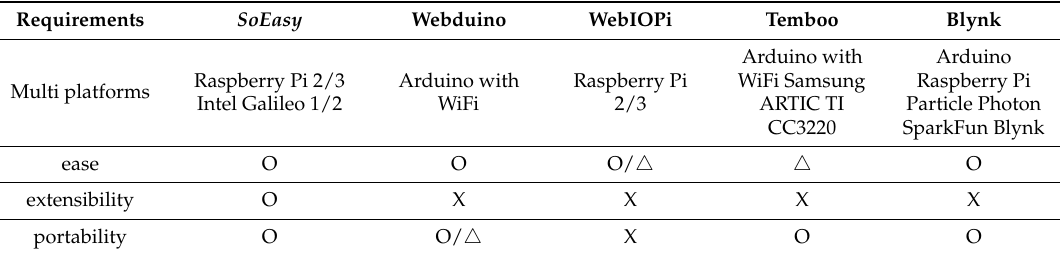
Figure 8. SoEasy programming interface. Table 2. Comparison SoEasy with the existing Web-based and mobile application-based IoT development frameworks. (O: Yes or Satisfactory, (cid:52) : Average or Some, X: